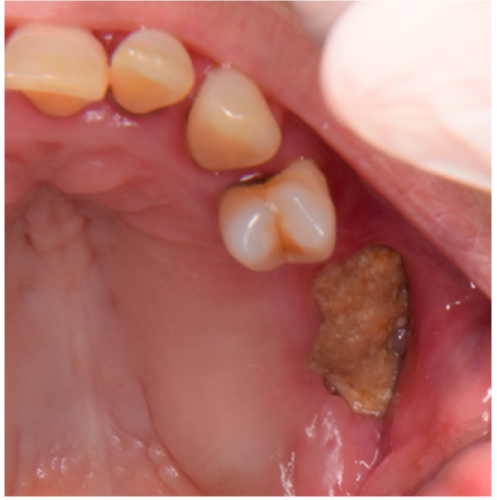
Figure 1. Exposed bone in the posterior area of the left upper jaw. A history of MM, diagnosed in May 2016, was recorded. In detail, MM was treated with lenalidomide, dexamethasone, bortezomib, and zoledronic acid for 18 months. After MM’s remission, MM maintenance therapy with lenalidomide alone was started in